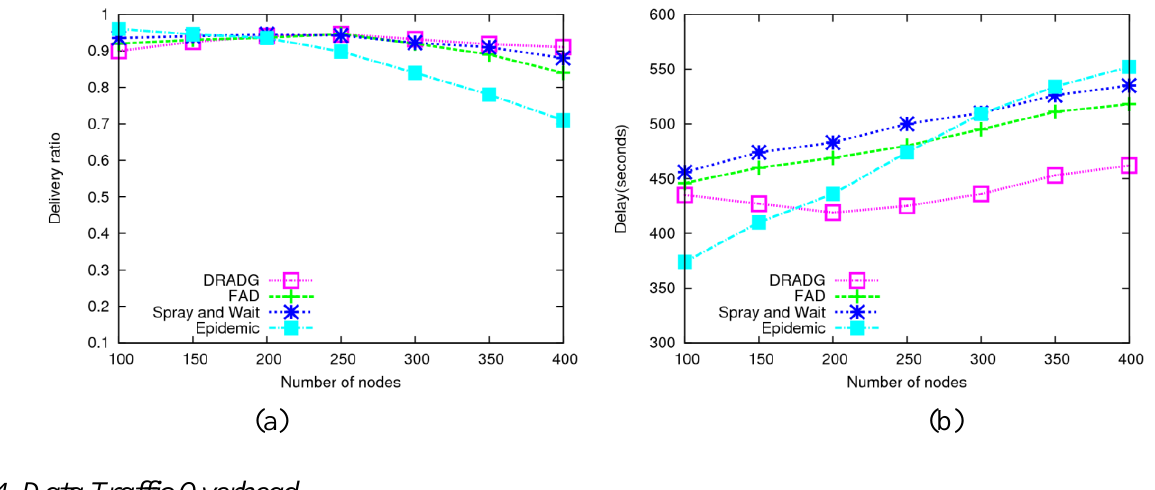
Figure 5. Impact of node density. (a) Average delivery ratio; (b) Average